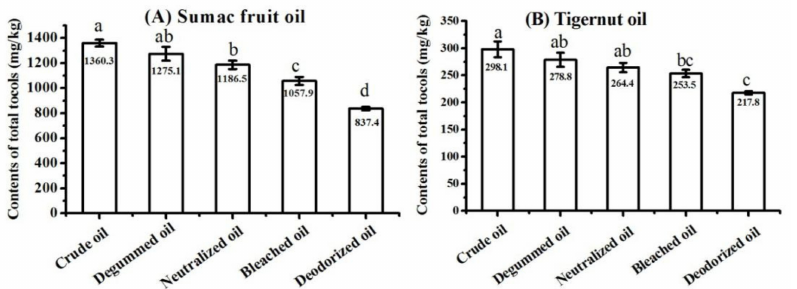
Figure 7. Content of total tocols in sumac fruit oil ( A ) and tigernut oil ( B ) at di ff erent refining stages (samples with the same letter in a column are not significantly di ff erent ( p < 0.05) n =